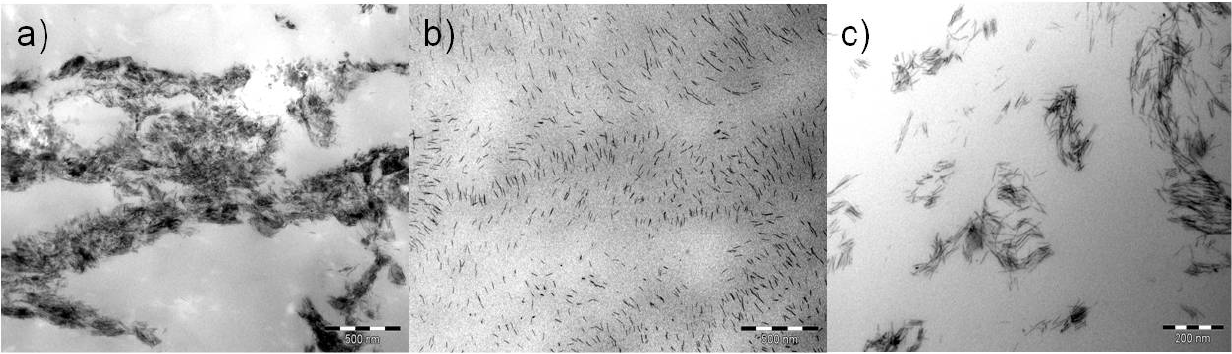
Figure 6. TEM micrographs of the 4 wt% cobalt nanorods embedded in the polymer matrix P41 ( a ) and ( b ) Scale bar: 500 nm ( c ) Scale bar: 200 nm.